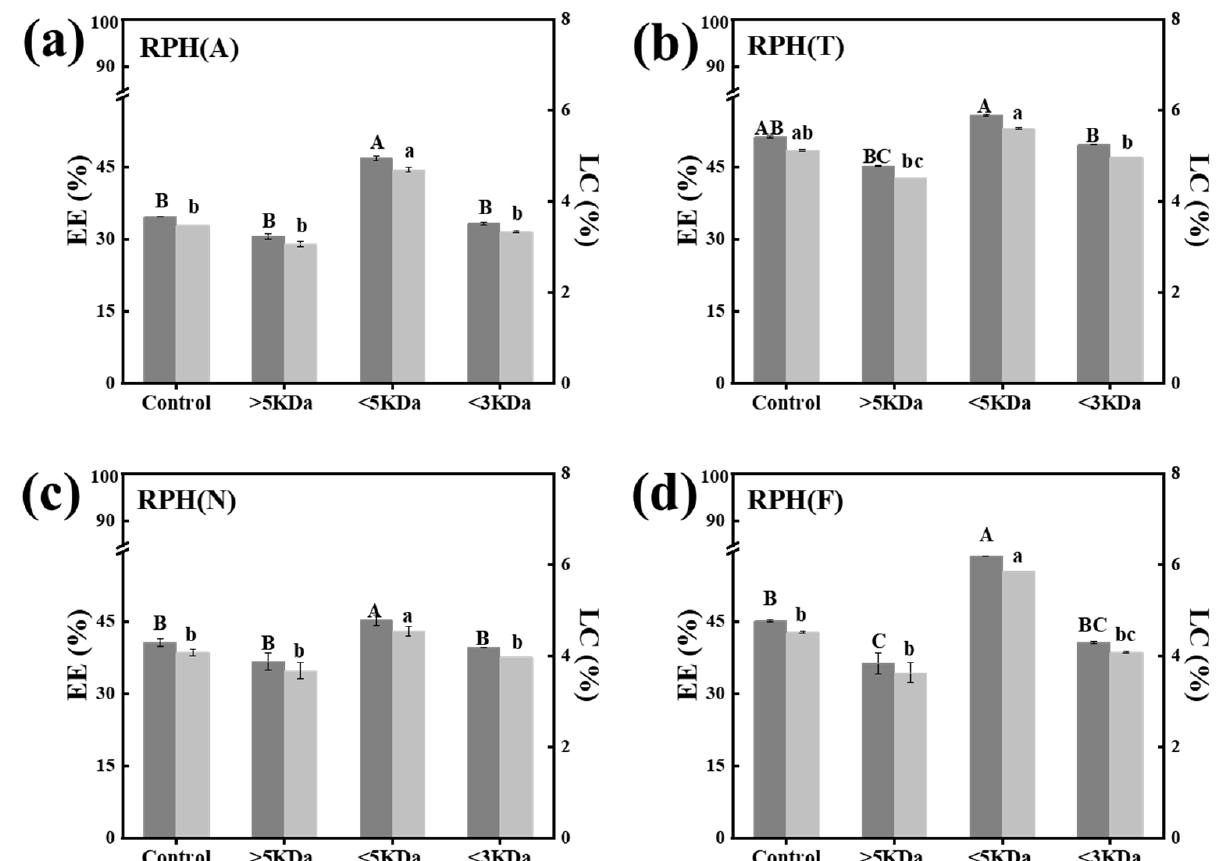
Figure 2. The encapsulation e ffi ciency (EE) and loading capacity (LC) of rice protein hydrolysate soy iso fl avone (RPH-SIF) nanoparticles with di ff erent molecular weights of RPH (( a ): RPH(A), ( b ): RPH(T), ( c ): RPH(N), and ( d ): RPH(F)), A–C Di ff erent superscript le tt ers represent a signi fi cant dif- ference (p < 0.01). a–c Di ff erent superscript le tt ers represent a signi fi cant di ff erence ( p < 0.05).